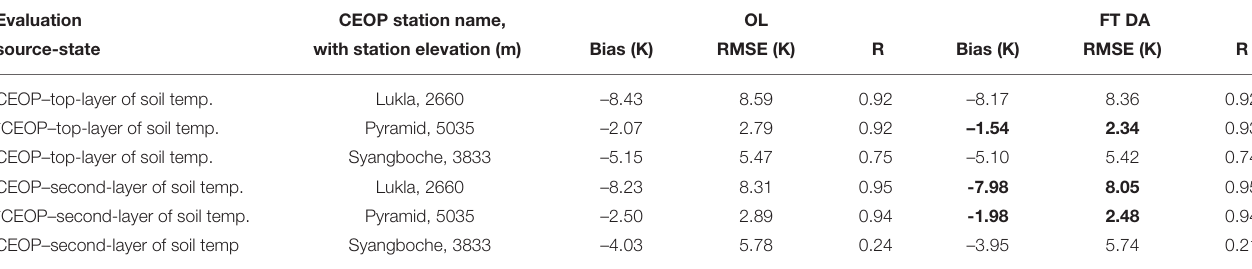
TABLE 4 | Statistics computed when comparing model derived, including both OL and FT DA derived, top-layer (0–10 cm) and second-layer (10–40 cm) of soil temperature estimates against measurements obtained from CEOP. Evaluation CEOP station name, OL FT DA source-state with station elevation (m) CEOP–top-layer of soil